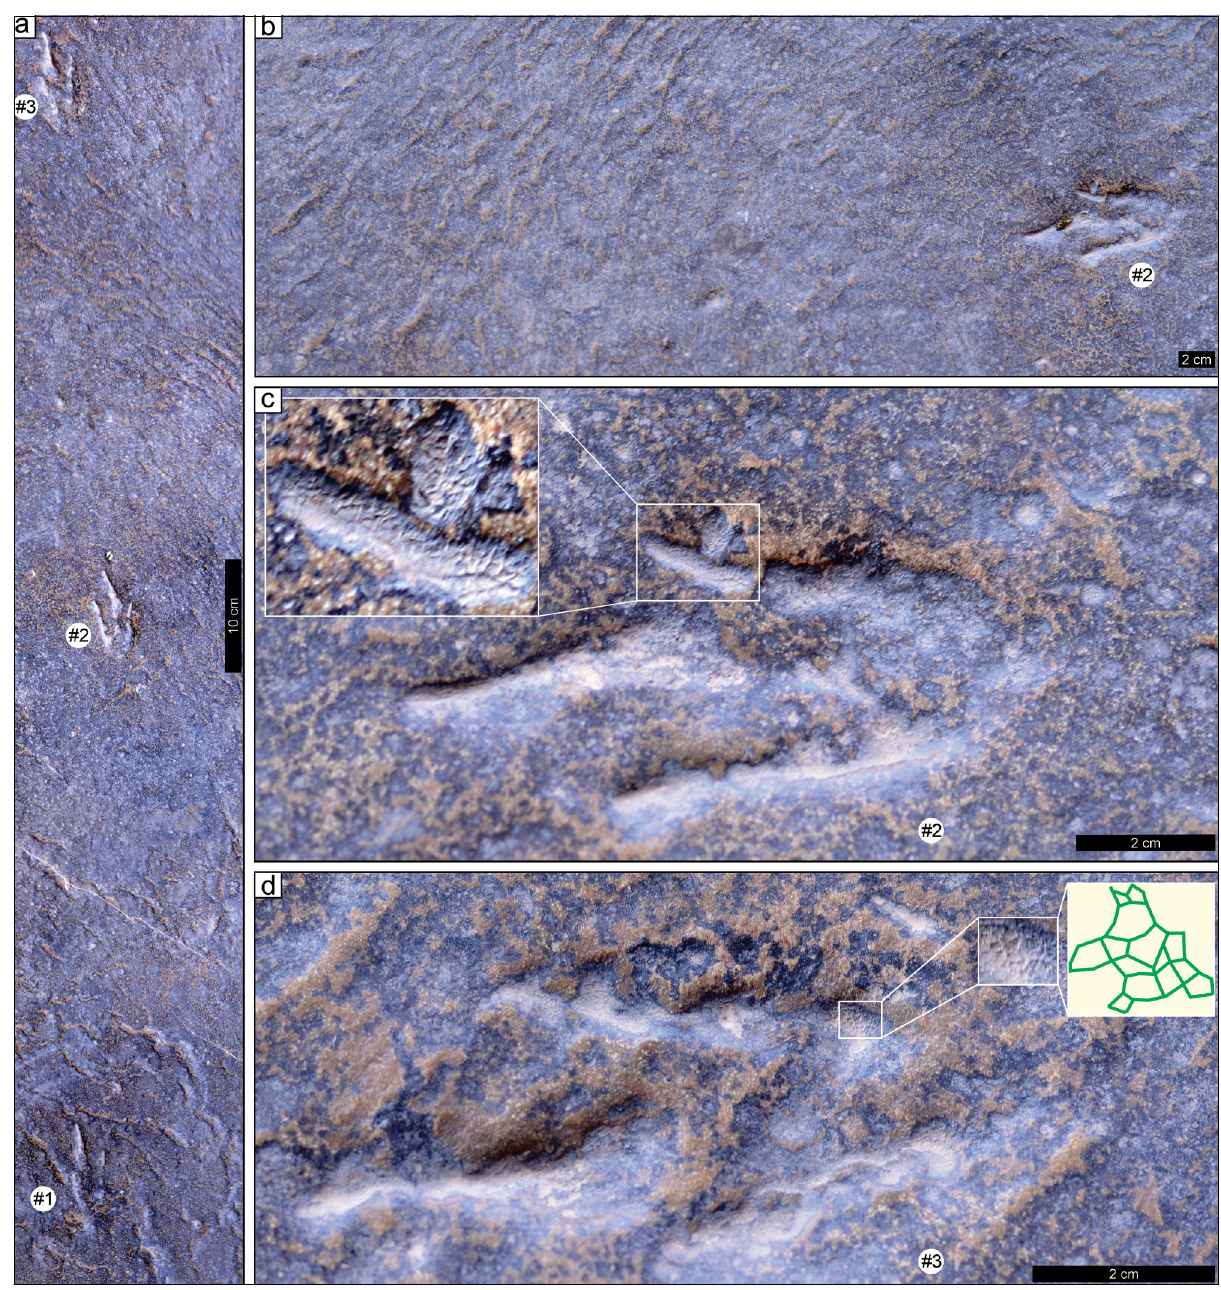
Figure 4: Details of the Grallator trackway in the lower Clarens Formation at the Storm Shelter ichnosite. (a) Orthophoto of the first three tracks within the trackway (image derived from photogrammetric model) showing random, parallel as well as curving ridges on the surface, which are interpreted as wrinkle structures – a type of microbially induced sedimentary structure. (b) Details of the tracking surface around track #2. (c and d) Close-up images of track #2 and #3 showing the millimetre-scale polygonal pattern inside small depressions both within and next to the tracks. The small-scale, polygonal pattern is interpreted as dried-out, microbially bound surfaces that draped the entire tracking surface soon after the tracks were formed. See Supplementary table 2 for trackway morphometric measurements, https://doi.org/10.6084/m9.figshare.13007240 for the trackway photogrammetric model and Supplementary figure 1 for further details on the sedimentological context of the